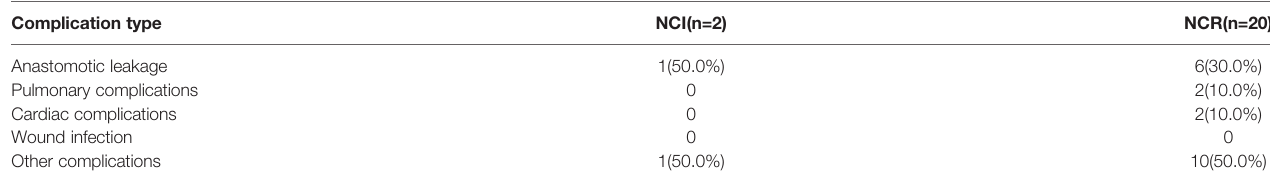
TABLE 6 | The classi fi cation of postoperative complications (CD>2).